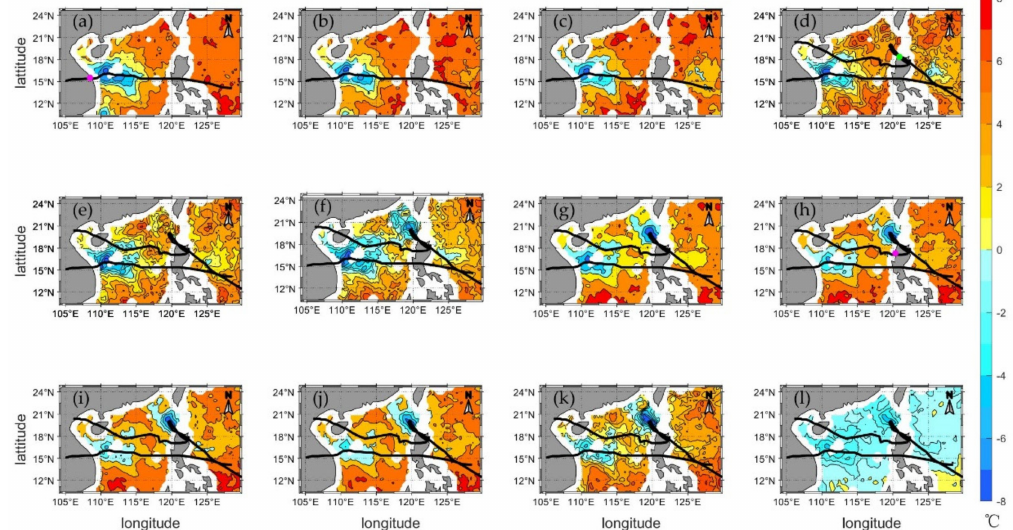
Figure 13. Surface temperature changes in the South China Sea after the passage of Typhoon Ketsana and Parma in 2009. ( a ) shows SSTA in the South China Sea on 30 September, ( b – l ) shows October 1st to 11th; ( a – e ) shows the separate track of typhoon Ketsana; ( f – l ) shows putting in the best path of